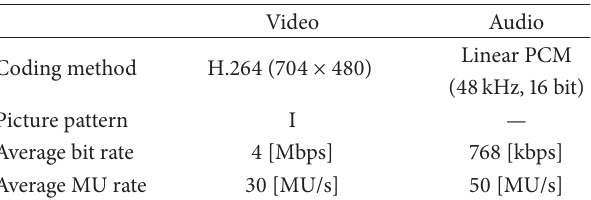
Table 1: Specifications of audio and video. Table 2: Pairs of polar